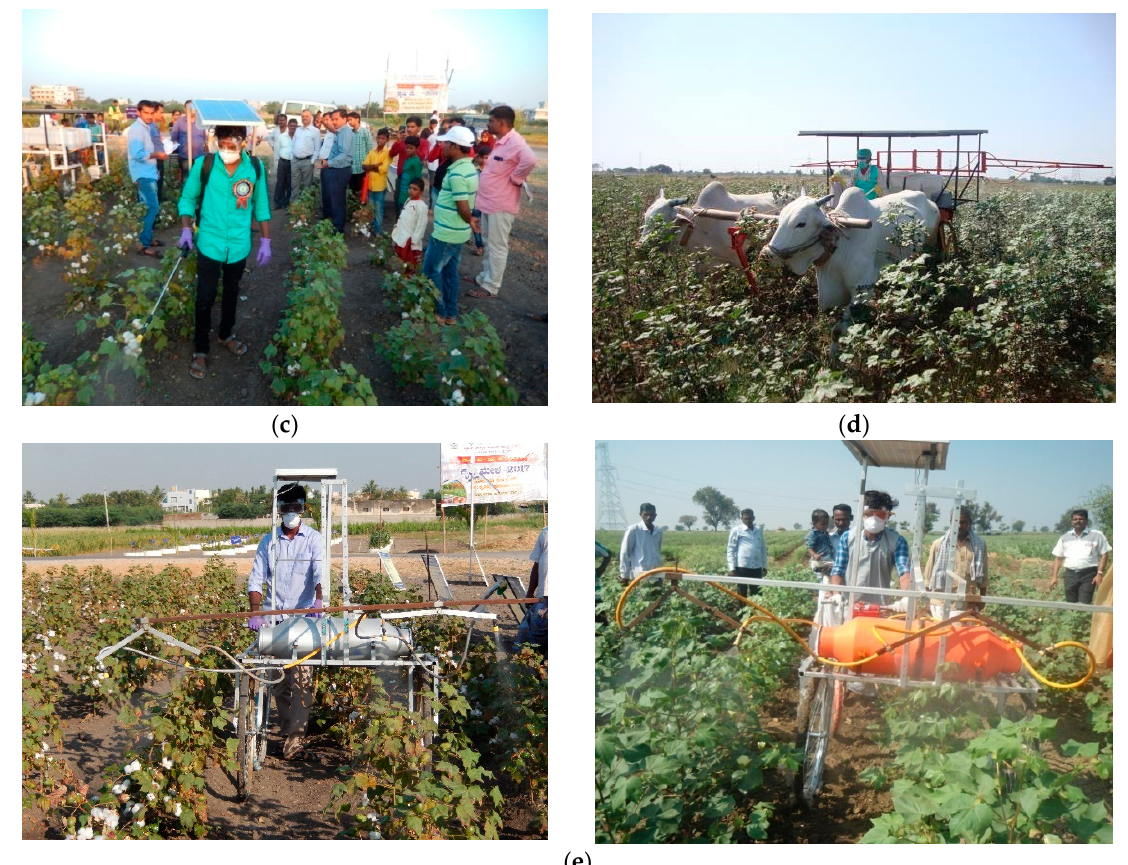
Figure 4. Different types of solar-powered sprayers. ( a ) Solar-powered knapsack sprayer; ( b ) utilization of solar-powered knapsack sprayer in onion field; ( c ) utilization of solar-powered knapsack sprayer in cotton field; ( d ) utilization of bullock-drawn solar-powered high-clearance sprayer in cotton field; ( e ) utilization of solar-powered push-type sprayer in cotton field.